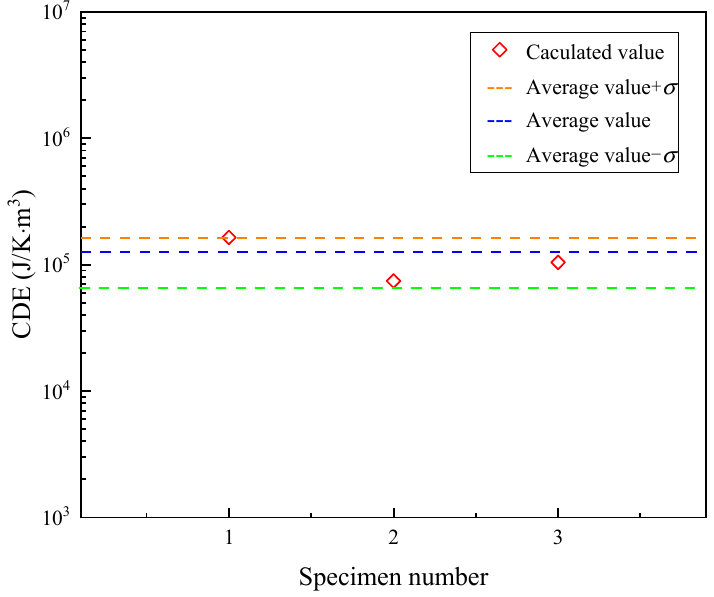
Figure 11. The CDE of three specimens with the stress amplitude of 148.5 MPa.